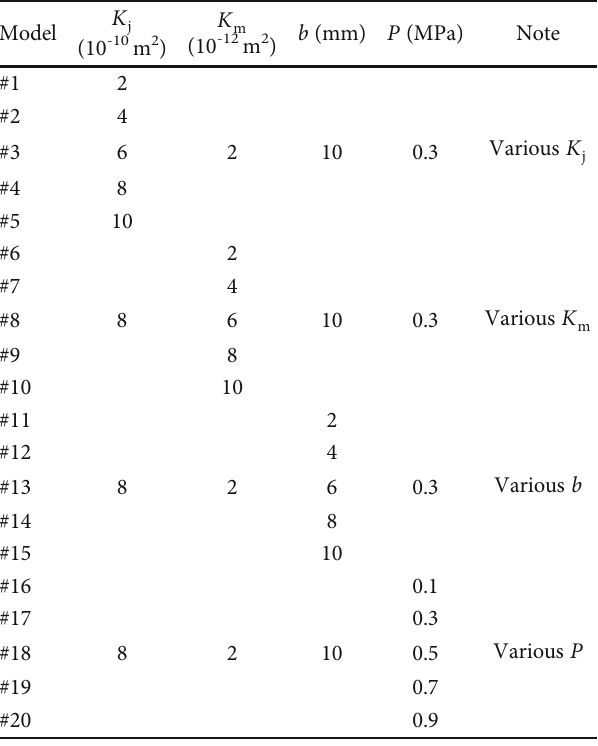
Table 2: Numerical simulation conditions in this